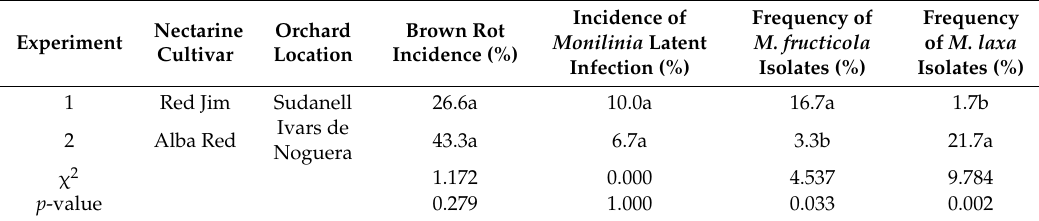
Table 2. The incidence of brown rot and latent infections caused by Monilinia spp. in harvested “Red Jim” and “Alba Red” nectarines after 7 days of incubation at 25 ◦ C under fluorescent lighting (100 µ E m − 2 s − 1 with a 16 h photoperiod) at 100% RH, and the frequency of Monilinia spp., which were isolated from the harvested nectarines before postharvest handling experiments (without any refrigeration